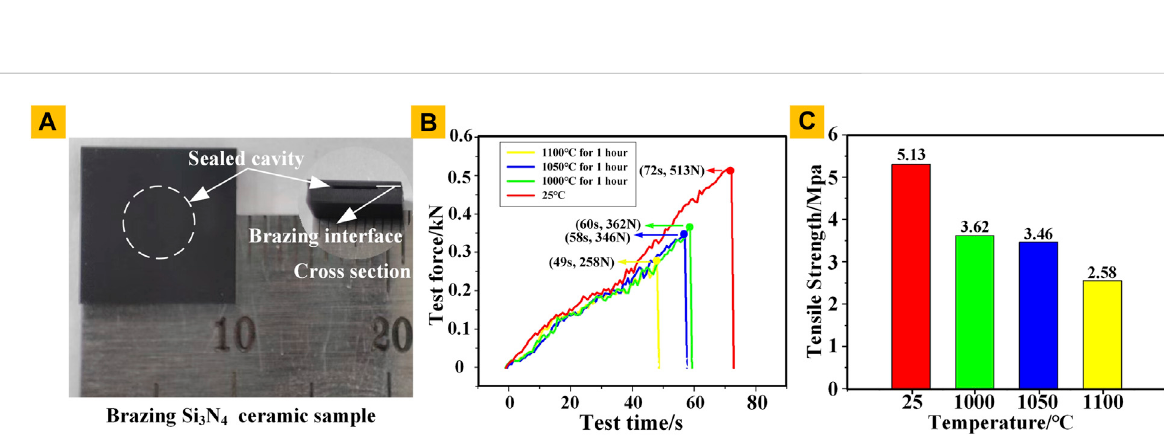
ceramic brazing interface. Form Figure 5A, the sealed cavity of the brazed sample remains intact, and the sample is adhesively fi xed to two vertical aluminum blocks and then mounted on the vertical fi xture of the stretching machine. The fi nal bonded interface fractured under a load of 513 N, and the bonded interface remained intact, thus indicating that the tensile strength of the bonded interface exceeded 5.13 MPa. To test the connection strength after the high temperature experiment, we placed the Si 3 N 4 ceramic